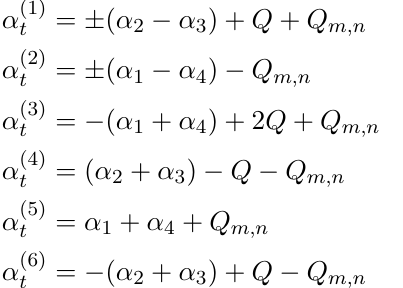
Figure 11 . The domain of < (cid:11) ( i ) the contour S of the integral over (cid:11) t